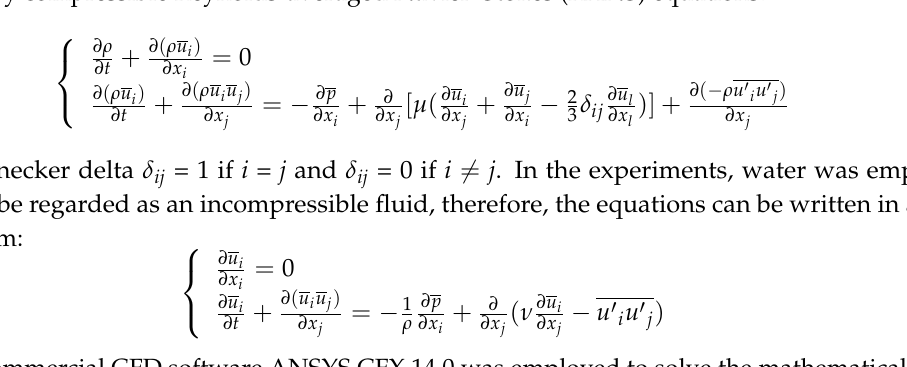
Table 2. Validation of grid independence. Mesh number (million)